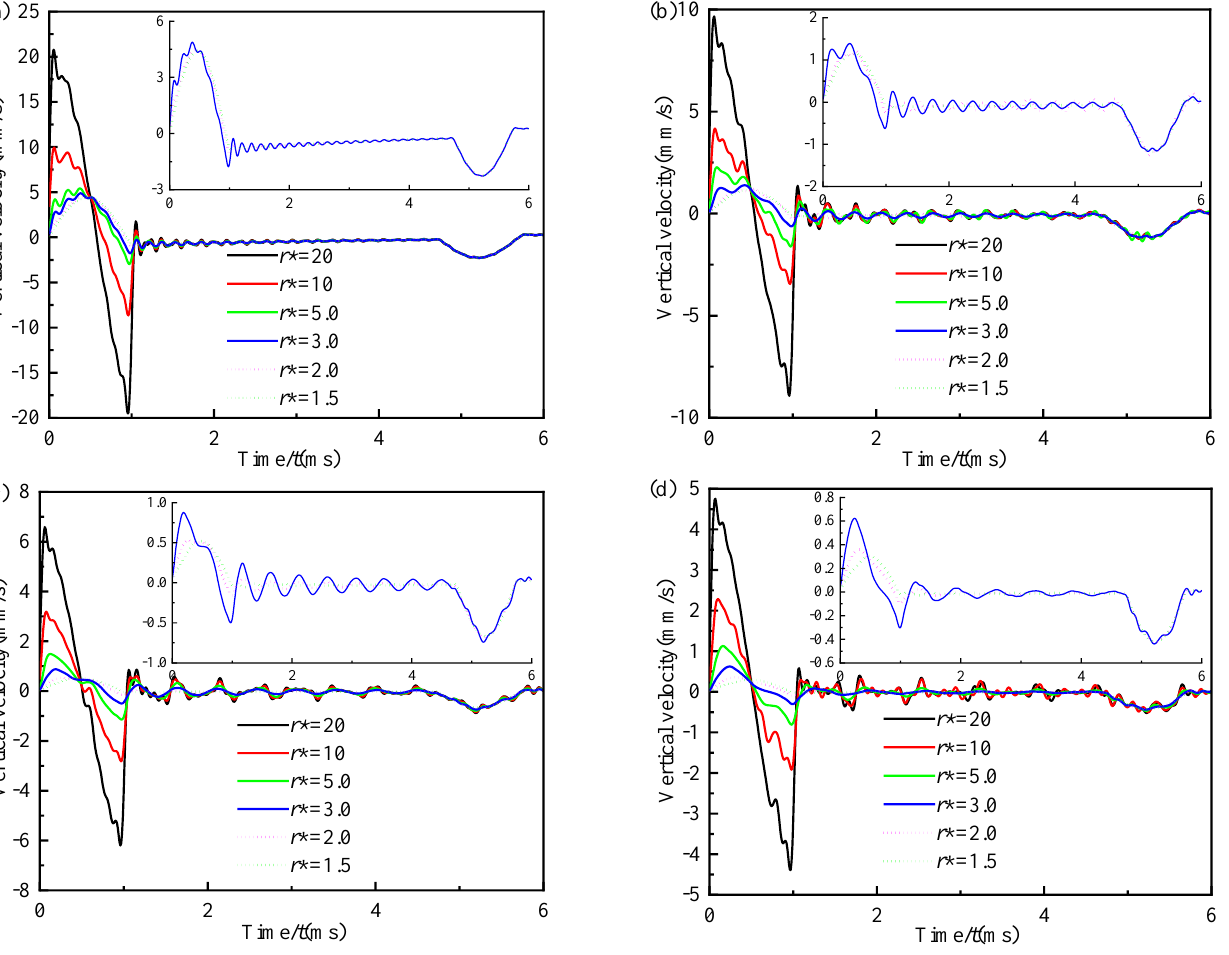
Figure 11. Vertical velocity time histories at the edge of the excitation region with different pile- hammer-ratios: ( a ) R = 0.25 m; ( b ) R = 0.5 m; ( c ) R = 0.75 m; ( d ) R = 1.0 m.